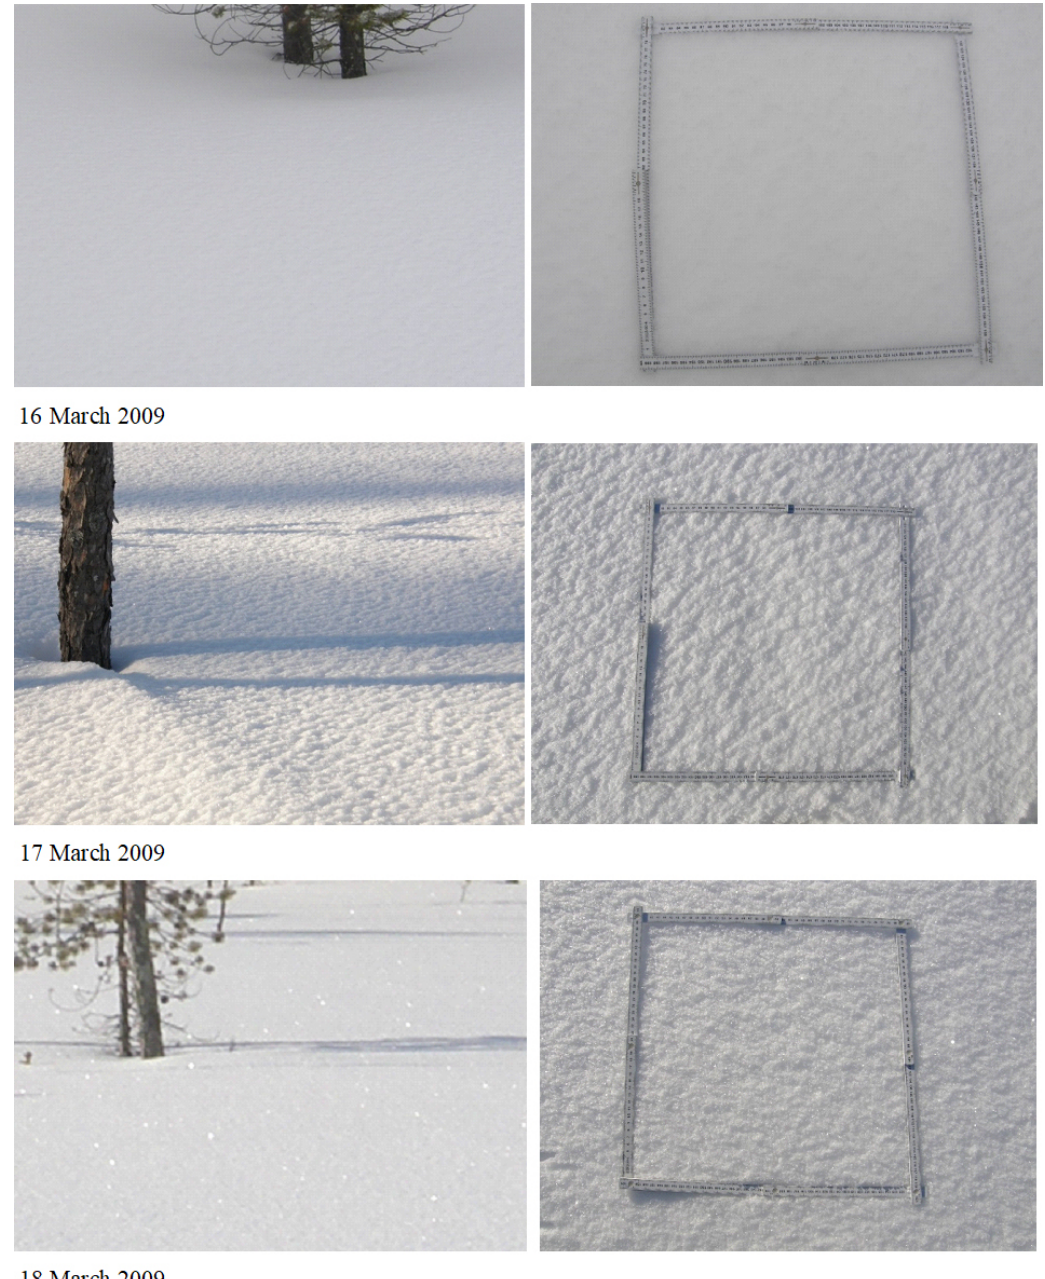
Figure 18. Snow surface structure evolution during 16–18 March 2009. The centimetre scale is shown in the right